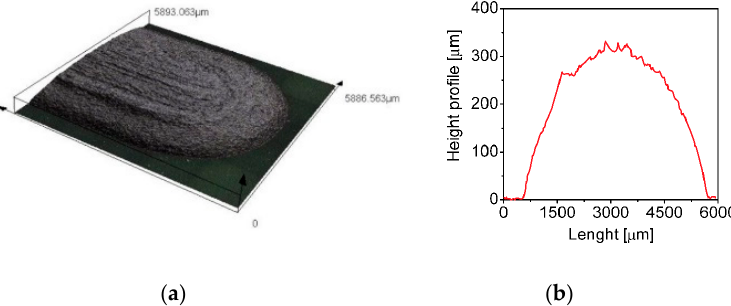
Figure 5. ( a ) Microscope image and ( b ) cross-section profile of microdispensed thick carbon electrode (CMD).